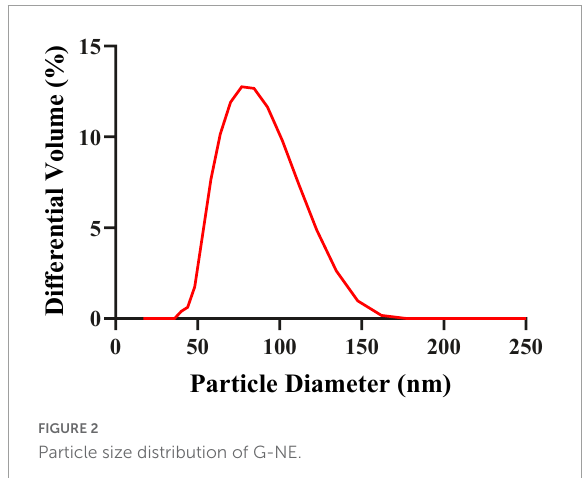
FIGURE2 Particle size distribution of G-NE.